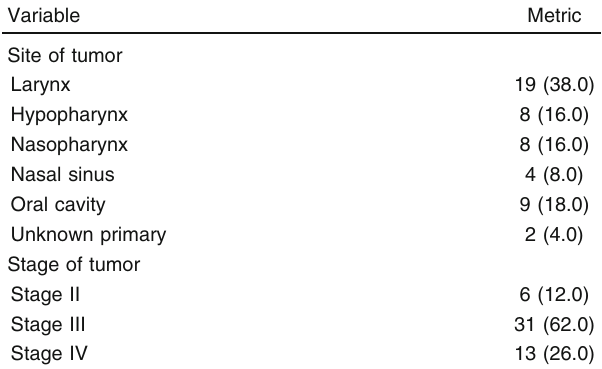
Table 2 Site and stage of head and neck tumors